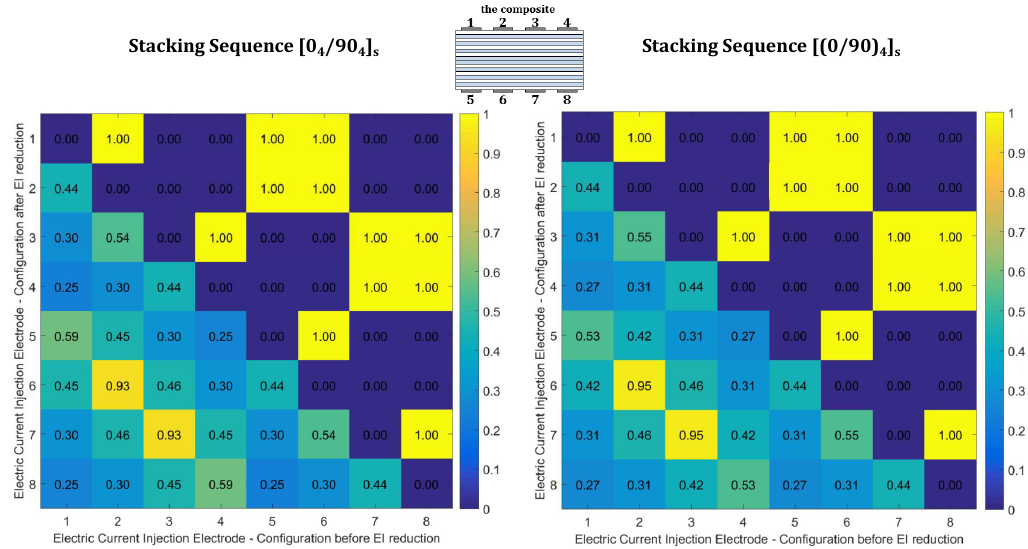
Figure 5. Graphical representation of effective independence values before and after electrode combination reductions for [ 0 4 /90 4 ] s ( left ) and [( 0/90 ) eight electrodes (the above diagonal indicates retained electrodes).